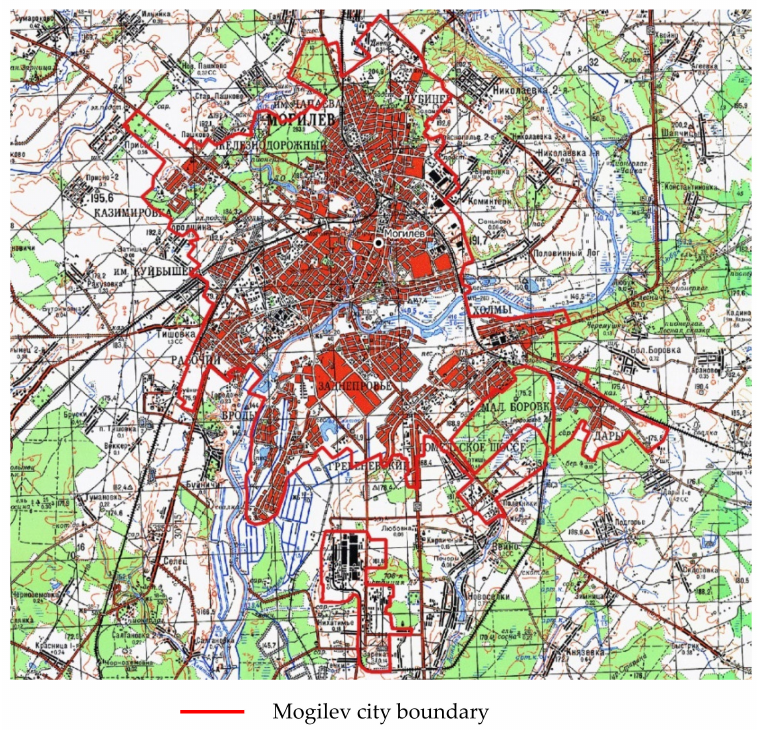
Figure A5. The Mogilev district map tile